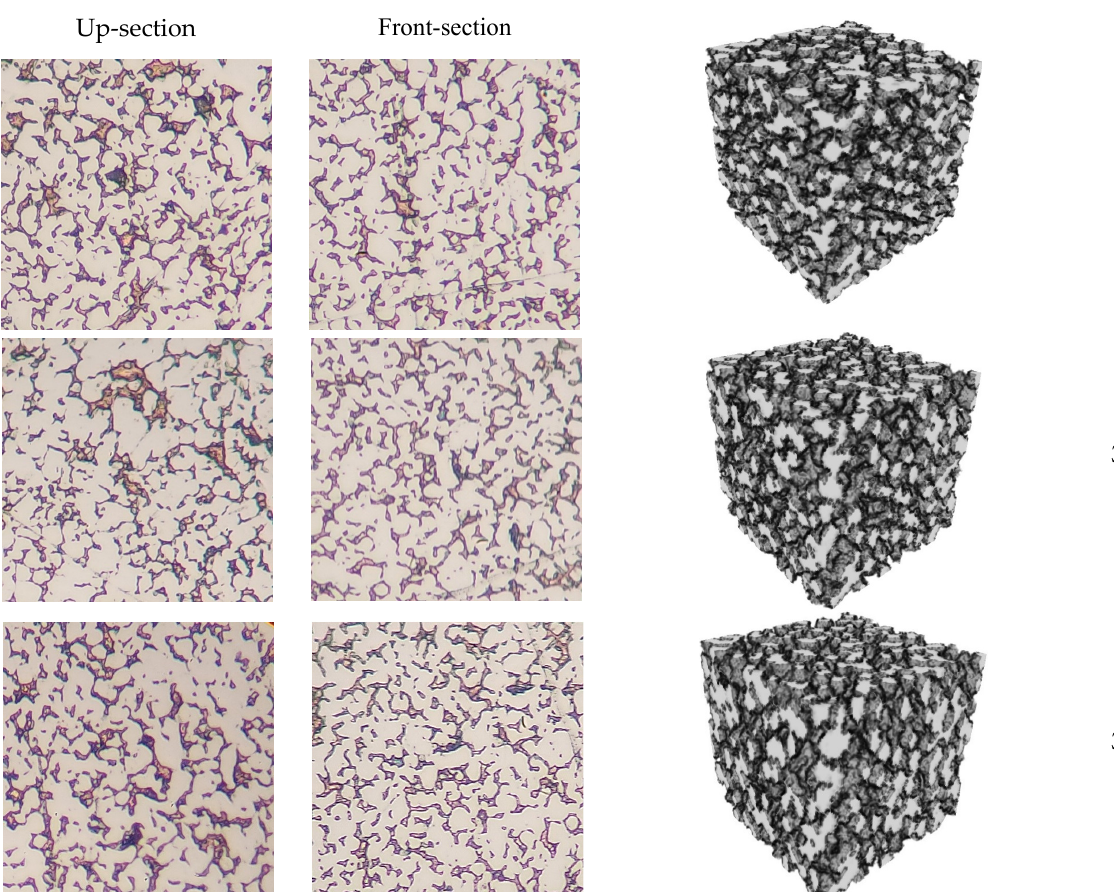
Figure 11. Estimated TCs of three experimental specimens using our method, searching for the